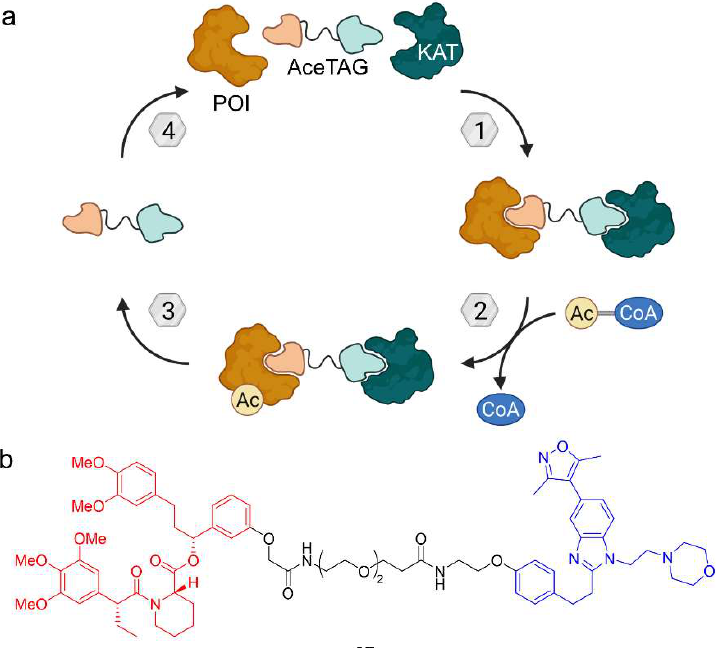
Figure 19. Target acetylation can be mediated by the acetylation-tagging (AceTAG) system. ( a ) Lysine acetyltransferases (KATs) are recruited to catalyze the transfer of an acetyl group from acetyl-CoA to the POI. ( b ) AceTAG-1 ( 37 ) is an acetylation-tagging molecule based on a FKBP12 ligand (red) and a ligand for the KATs CREBBP/p300 (blue). The CREBBP/p300 ligand binds the bromodomain and does not block the KAT domain for acetylation of FKBP12-based POI fusion proteins.